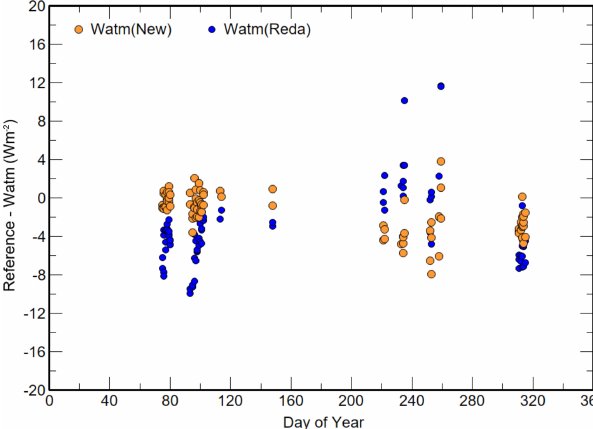
Figure 11. The two slope contributions to <K 1 > for the equation developed by Reda et al. (2012).